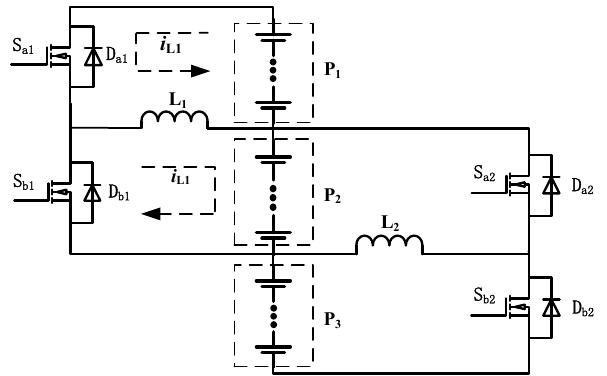
Figure 6. The equalization process of top layer equalization circuit.